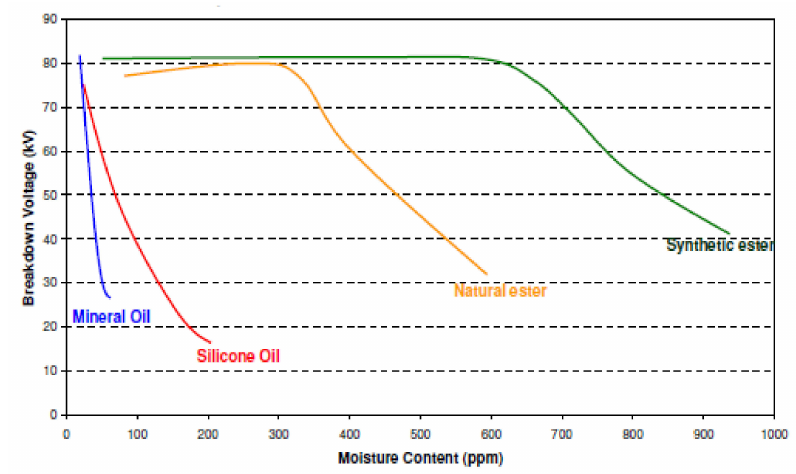
Figure 5. Impact of absolute humidity content on AC BDS of di ff erent fluids [5] with permission from